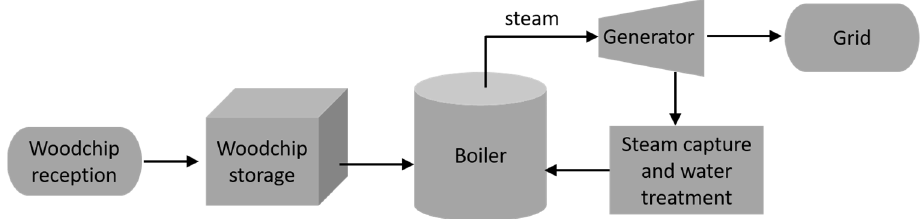
Figure 5. The process for directly burning dried woodchips in a combustor to generate steam in a boiler. The steam is sent through a turbine and electricity is generated that is sent to the